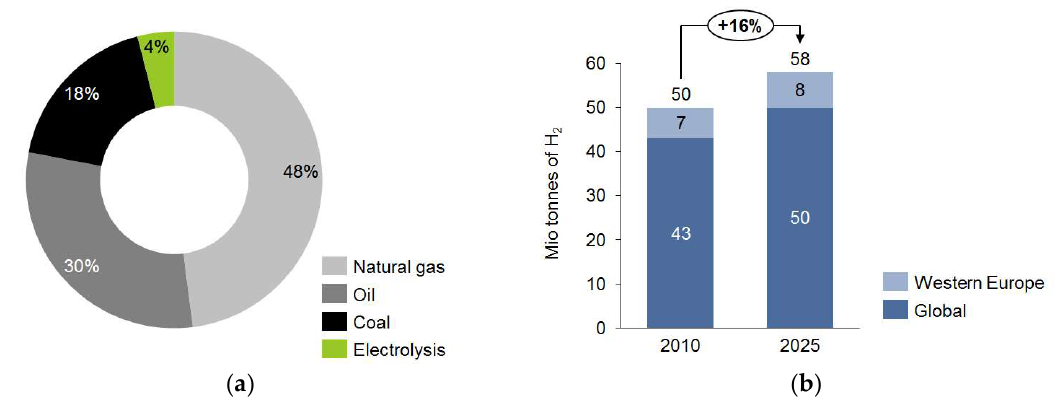
Figure 1. Hydrogen sources ( a ) and overall hydrogen production in Western Europe and worldwide ( b ) [1].